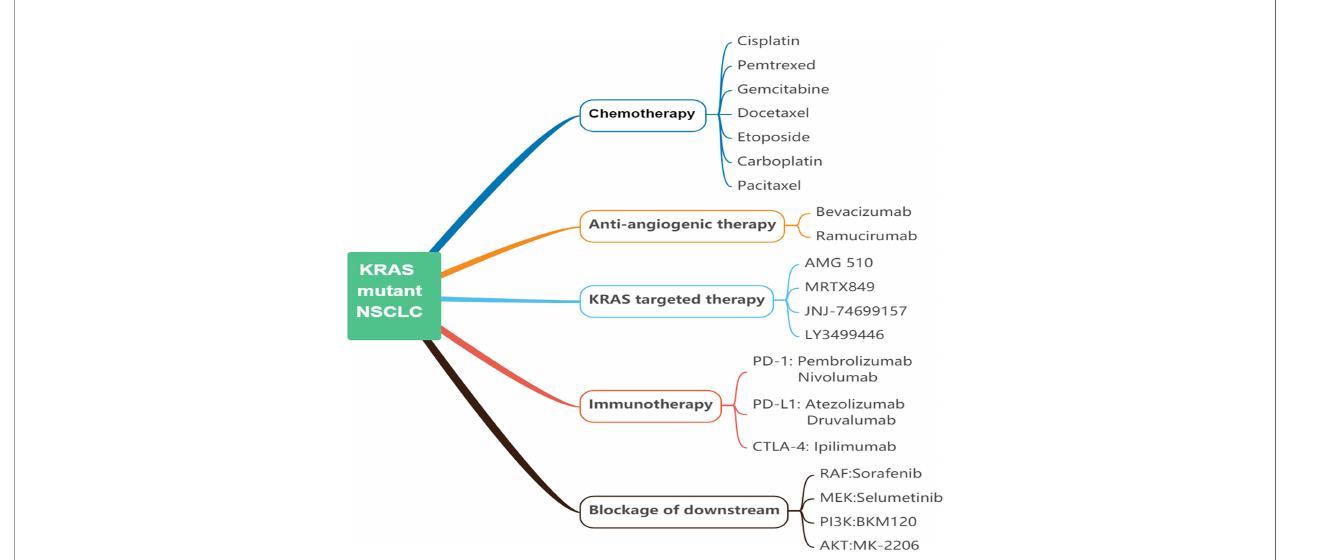
FIGURE 4 | Current approaches of KRAS-mutant NSCLC. NSCLC, non-small cell lung cancer; KRAS, kirsten rat sarcoma viral oncogene homolog; PD-1, programmed cell death protein 1; PD-L1, programmed cell death-ligand 1; CTLA4, cytotoxic T-lymphocyte-associated protein 4; Raf, rat fi brosarcoma; MEK, mitogen-activated protein kinase kinase; PI3K, phosphoinositide 3-kinase; Akt/PKB, protein kinase